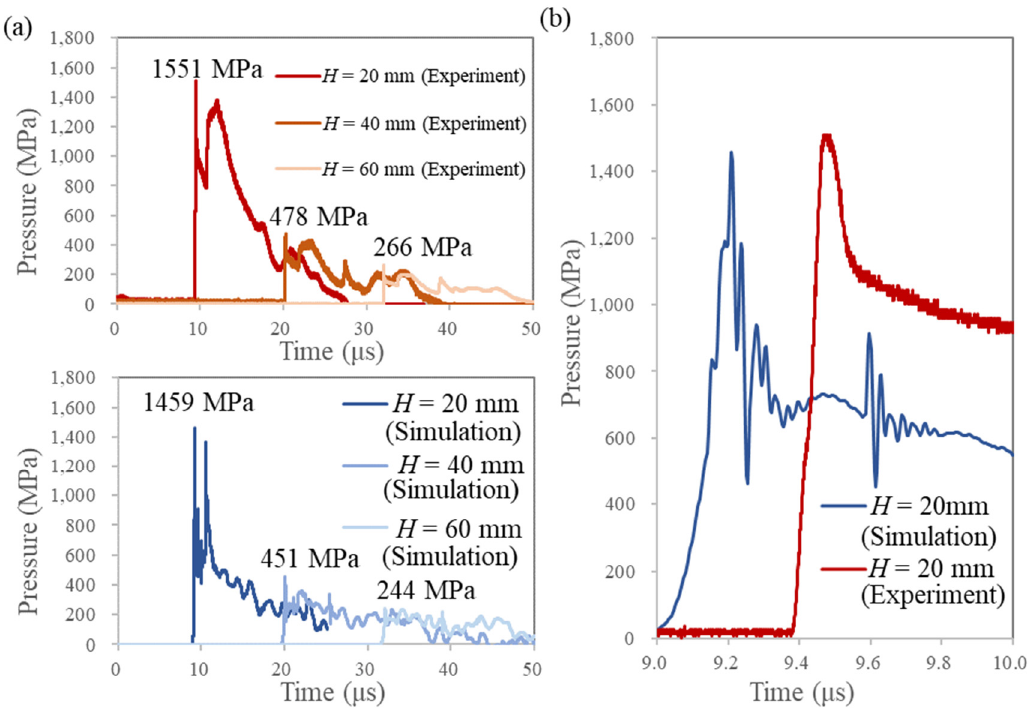
Figure 5. Comparison of the pressure histories received from experimental and numerical simulations. ( a ) Comparison of the peak pressure values and shapes at different values of H . ( b ) Comparison of the pressure rise process for H = 20 mm.